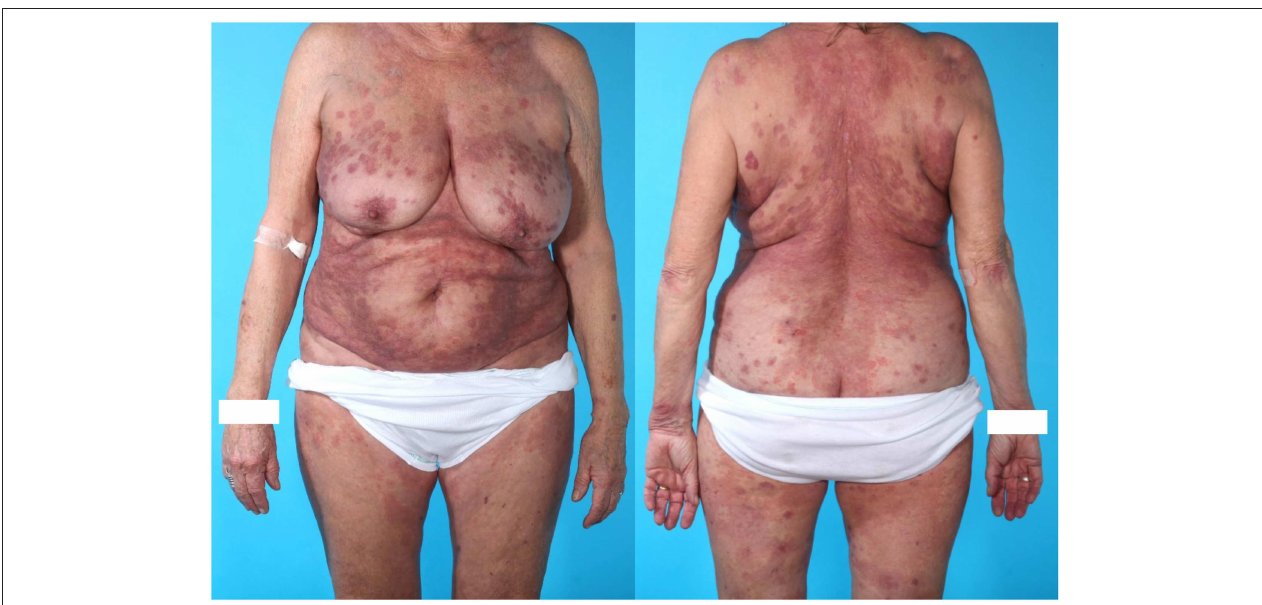
FIGURE 2 | Seventy six years old (at diagnosis of PV) ethnically danish woman with mucocutaneous PV, celiac disease, and former dermatitis herpetiformis as well as essential hypertension. The patient did not receive treatment with ACE inhibitor. Skin biopsy showed acantholysis. DIF on the skin biopsy showed intercellular deposition of IgG. The patient was treated with oral prednisolon, Methotrexate and two times Rituximab. Time to remission was 20.7 weeks which is close to mean time to remission (19.9 weeks) in the 19 included patients. The patient received a total dose of 2,495mg prednisolone, which placed her in the “low dose prednisolone” group. This patient was later diagnosed with osteoporosis on DXA